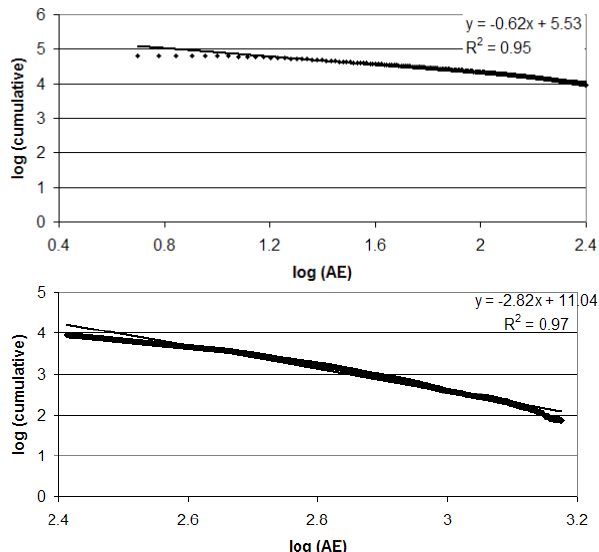
Fig. 4. Magnitude-frequency distribution for the AL index over − 800nT (quiet – top) and less than − 800nT